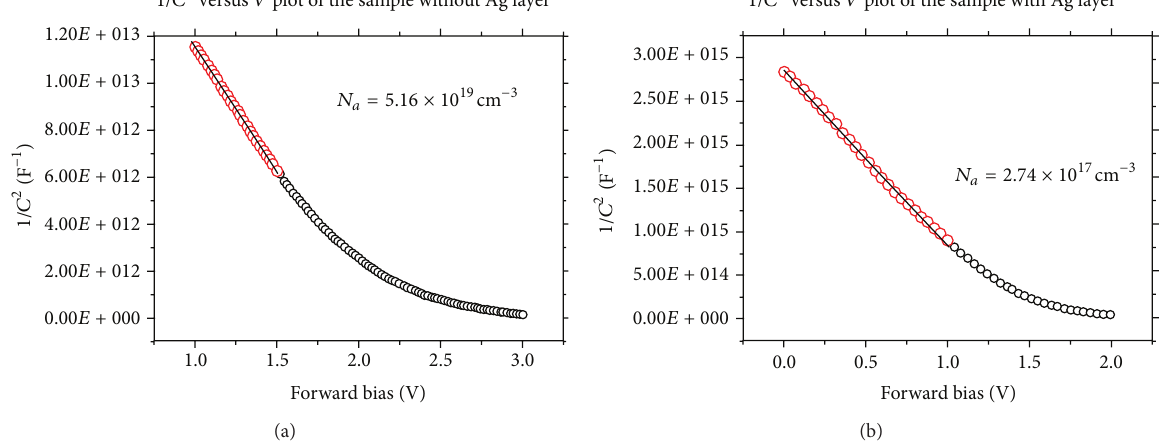
Figure 4: 1/𝐶 2 versus 𝑉 plot of (a) the cell without Ag layer and (b) the cell with Ag layer. The slope is extracted by linear fitting of the linear data (red